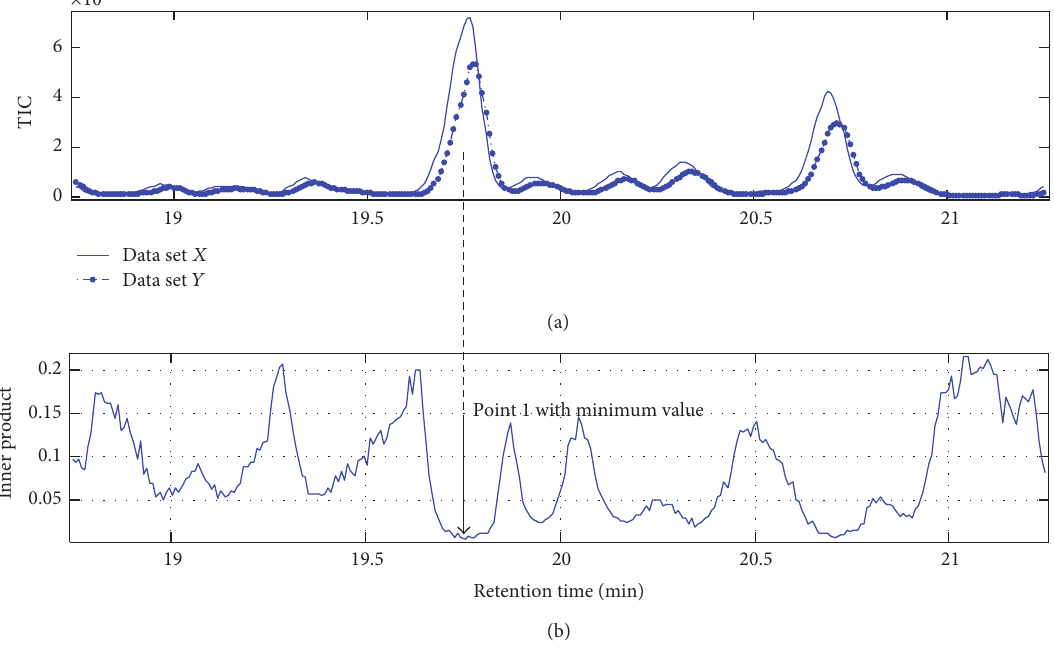
Figure 4: An example of how to obtain the exact retention time information of the target component using the ATS method for alignment. (a) Total ion chromatograms of ginseng data sets X and Y as examples; (b) the residual graphs of data set X projected onto Y . Point 1 shows the retention time position with the minimum value of the inner product corresponding to the target